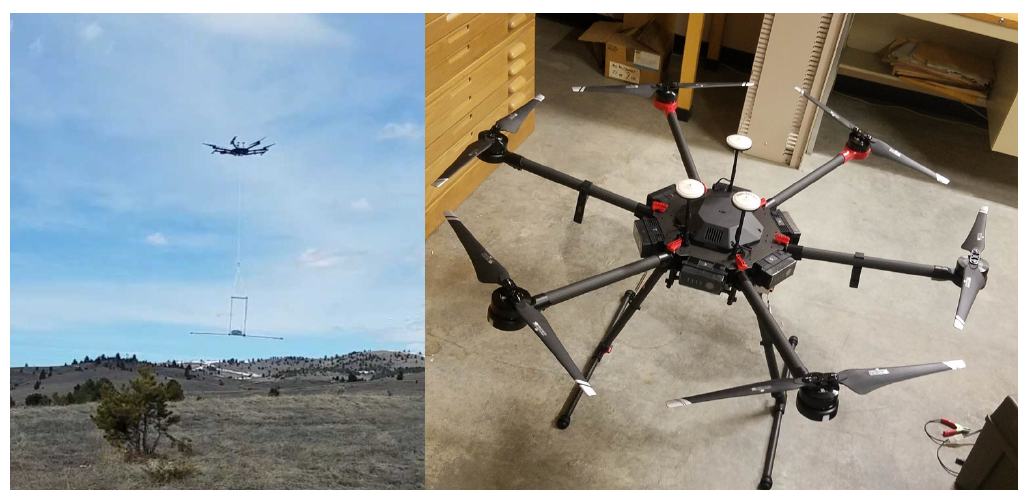
Figure 4. Left panel: The magnetic gradiometer towed beneath the UAS while in flight. Right panel: A close-up of the DJI Matrice 600 Pro used for the project.